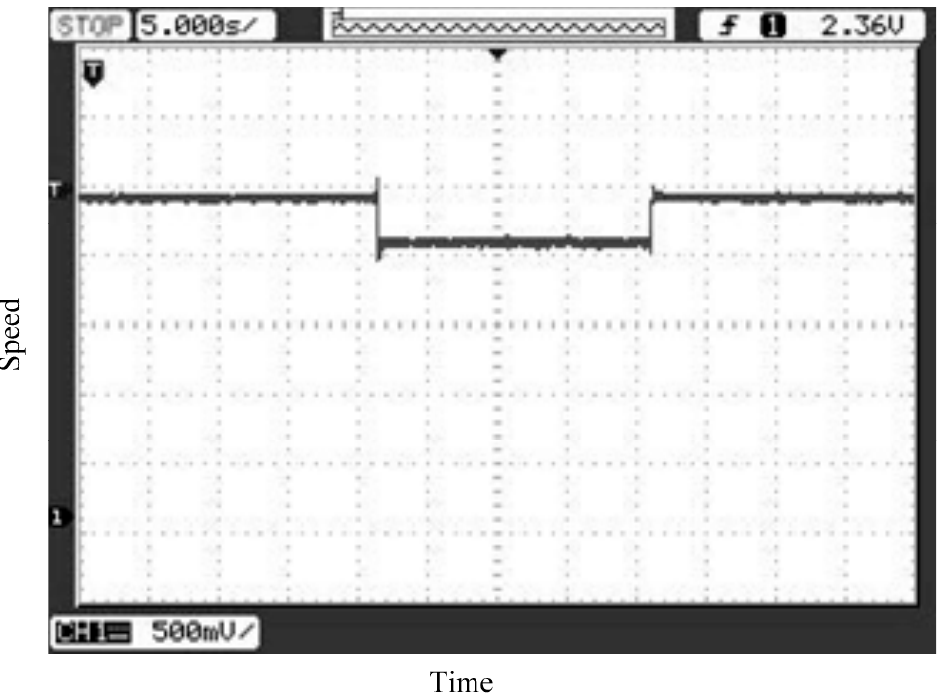
Figure 14. The transient performance of the entire drive system under variable speed from 0.4 pu to 0.2 pu to 0.4 pu.